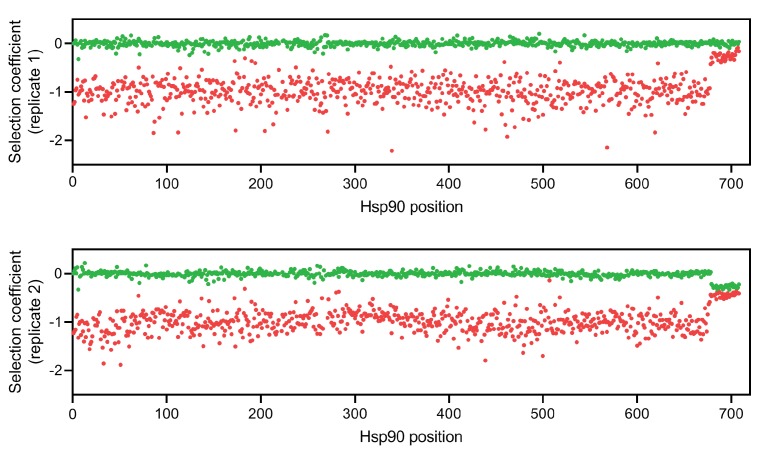
Selection coefficients for wild-type synonyms (green) and stops (red) at each position of Hsp90 for both replicates of standard conditions.